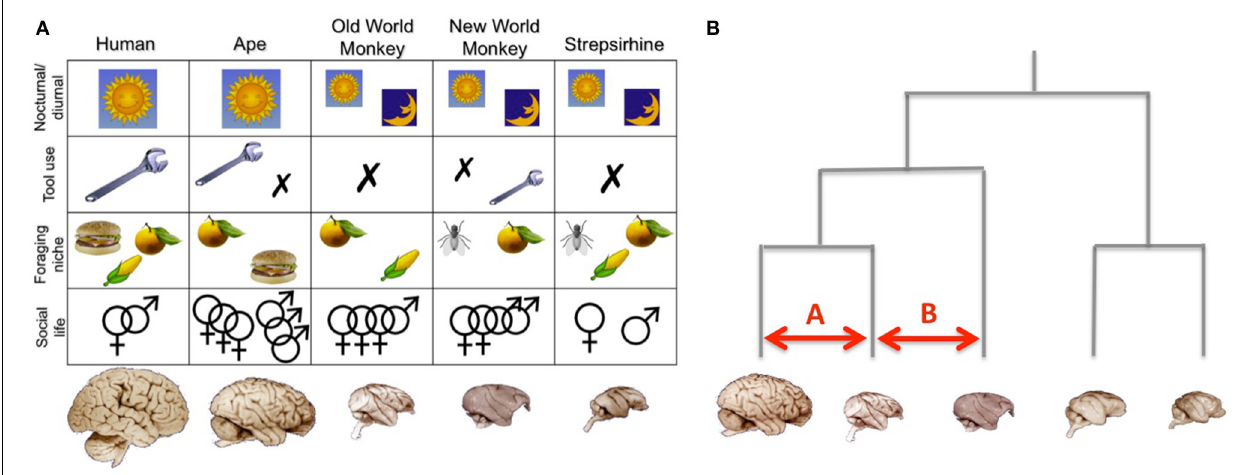
FIGURE 3 | Analysing the relationschip between brains and behaviors. (A) In a multivariate comparative approach, each brain is viewed as a unique combination of variables, including whether the animal is active during night or day, whether it uses tools regularly, occassionally, or not at all, its diet, and the complexity of its social life. By using a whole-brain and multi-variate approach it is possible to investigate how differences in specific aspect of brain organization are related to different ecological variables. Note that this figure merely represents an idealized illustration. (B) Phylogenetic analyses take into account the evolutionary